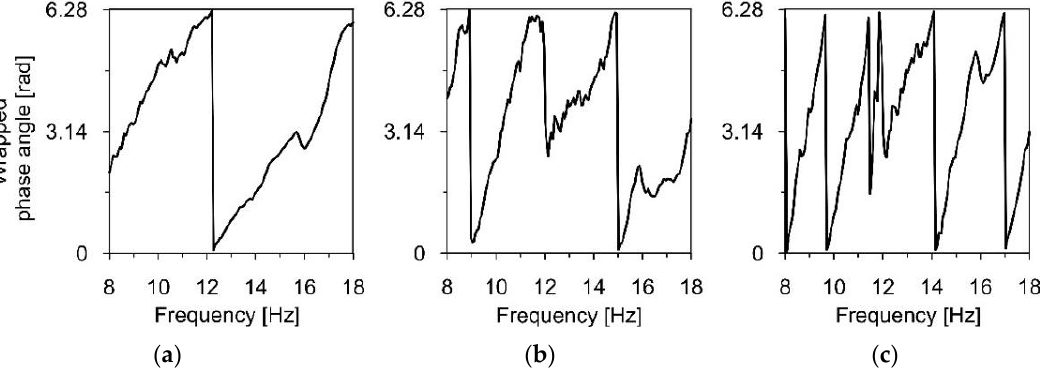
Figure 12. The function of phase angle in wrapped form for pairs: ( a ) P1 – P2, ( b ) P1 – P3, ( c ) P2 – P3.